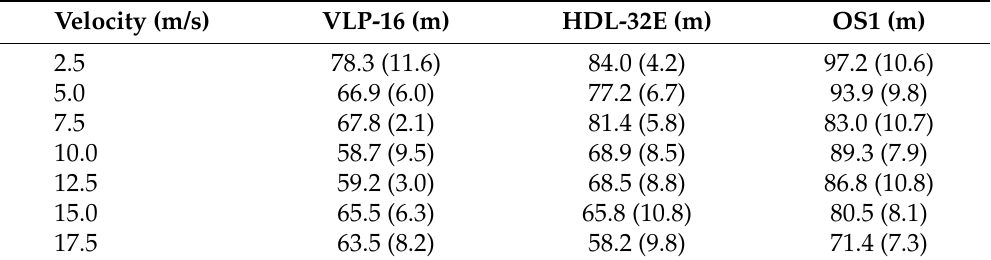
Table 4. Detection ranges measured in physics-based simulations of UAV-mounted lidar with 25 trials at each velocity. The one standard-deviation error bars are listed in